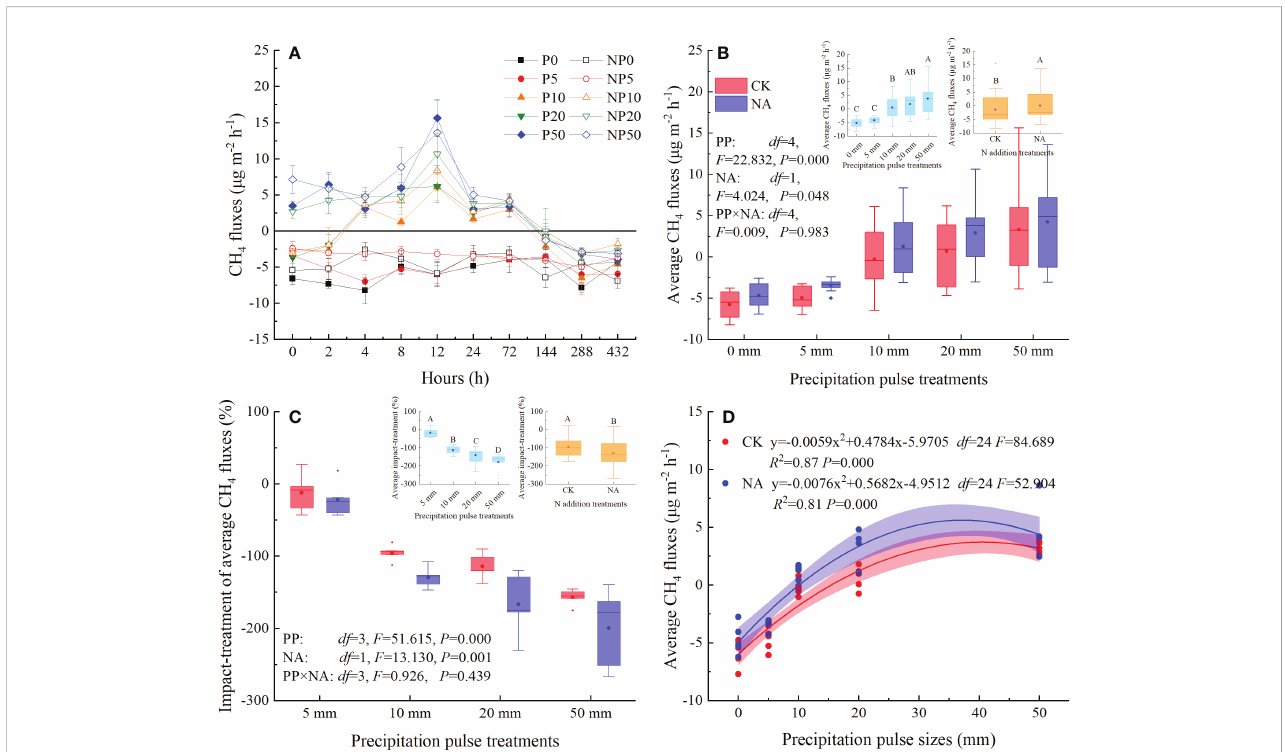
FIGURE 4 Responses of CH 4 fl uxes ( (A) : temporal dynamic; (B) : average fl ux; (C) : impact-treatment of average CH 4 fl ux) to precipitation pulses and N addition treatment, and the relationship between average CH 4 fl uxes and precipitation pulse sizes (D) . The inserted graphs (light blue column) in panels B, C show the differences in average CH 4 fl uxes and impact-treatment of average CH 4 fl ux among the precipitation pulses. The inserted graphs (orange column) in panels B, C show the differences in the average CH 4 fl uxes between the control and the N addition treatments. Boxplots show the median (lines within the box) and interquartile range (box boundaries). Whiskers extend to the most extreme data point within 1.5 × (75-25%) data range. The solid point represents the mean value. Different capital letters (above each boxplot) denote signi fi cant differences among the precipitation pulses or between the control and N addition